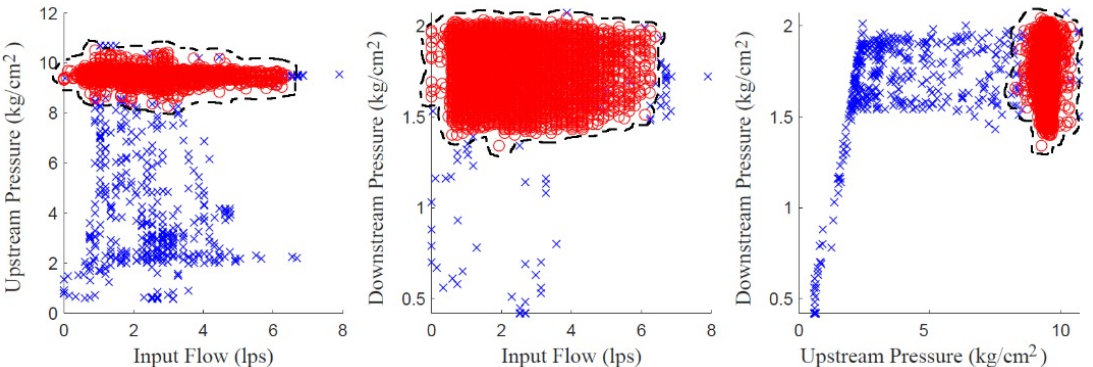
Figure 4. Data space projections of the features: normal conditions in red ◦ , anomalies conditions in blue ×